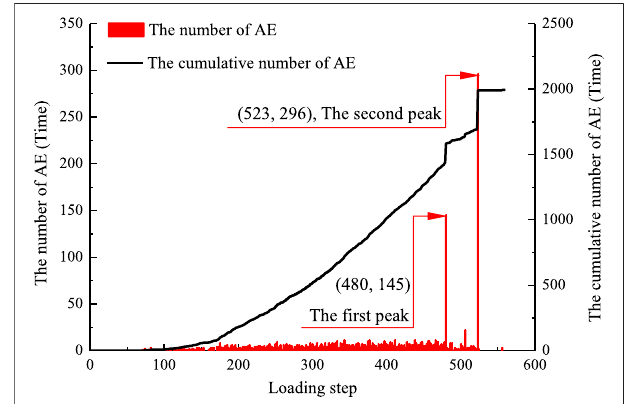
FIGURE 11 | AE curve of anchored rock with the negative Poisson ’ s ratio bolt.